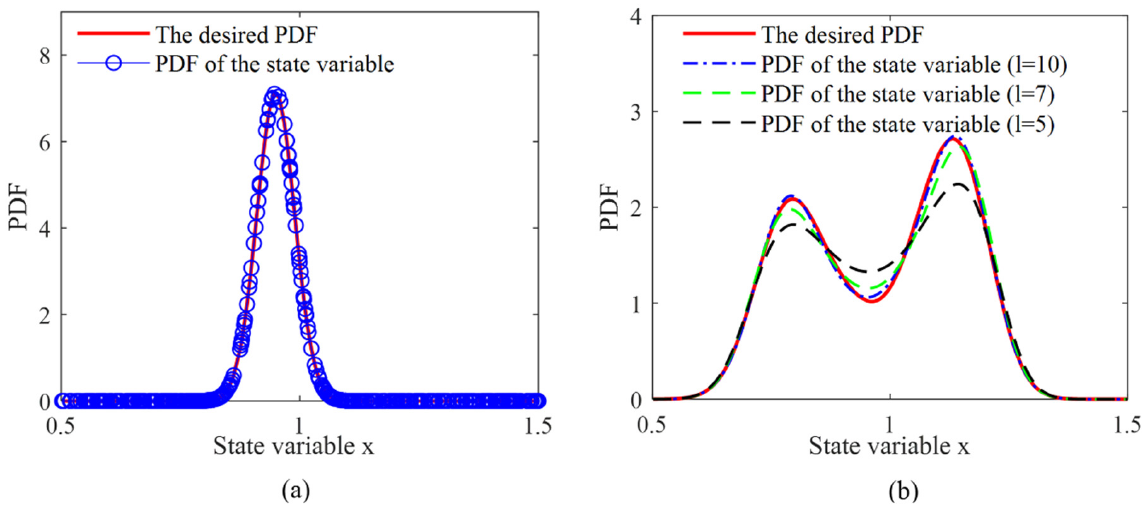
Figure 5. The tracking result under different rotor speed distributions: ( a ) when the goal function is unimodal Gaussian distribution; ( b ) when the goal function is variable weight multi-Gaussian distribution.